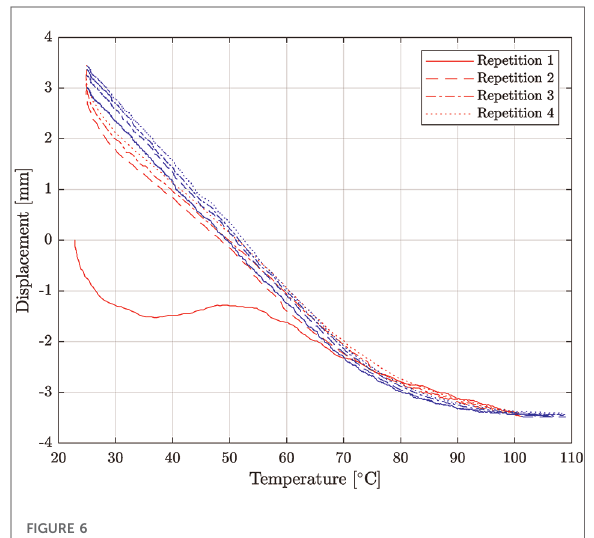
FIGURE 6 Four consecutive cycles of TCA heating from 25 (cid:1) C to 100 (cid:1) C after not being used overnight. The red and blue represent the heating and cooling portions of the cycle, respectively. The heating curve of the fi rst repetition is signi fi cantly different from the rest of the trajectories.